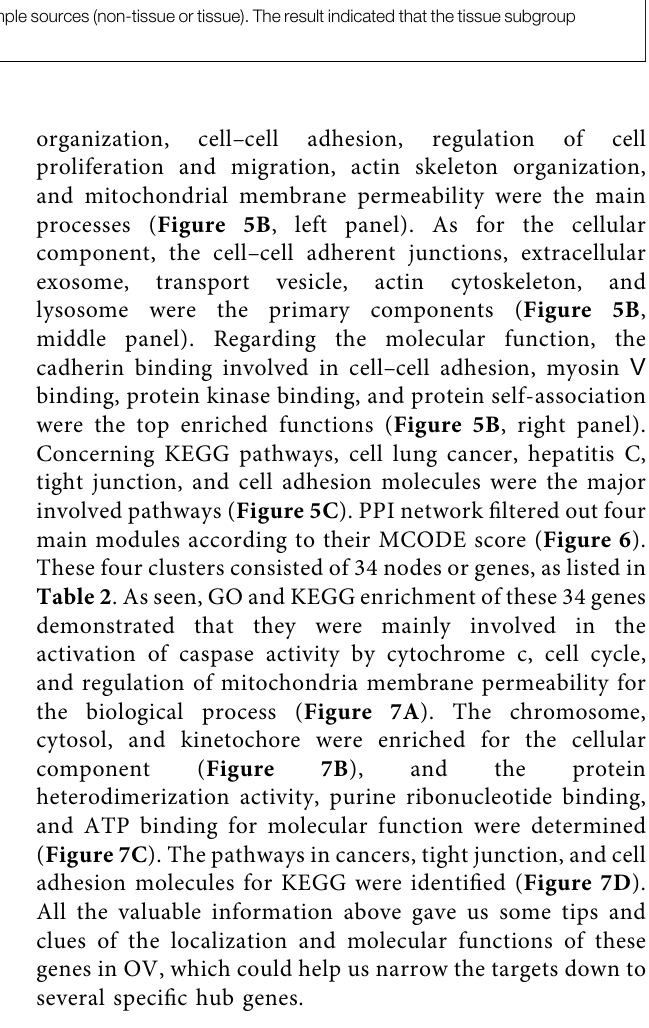
Frontiers in Molecular Biosciences |